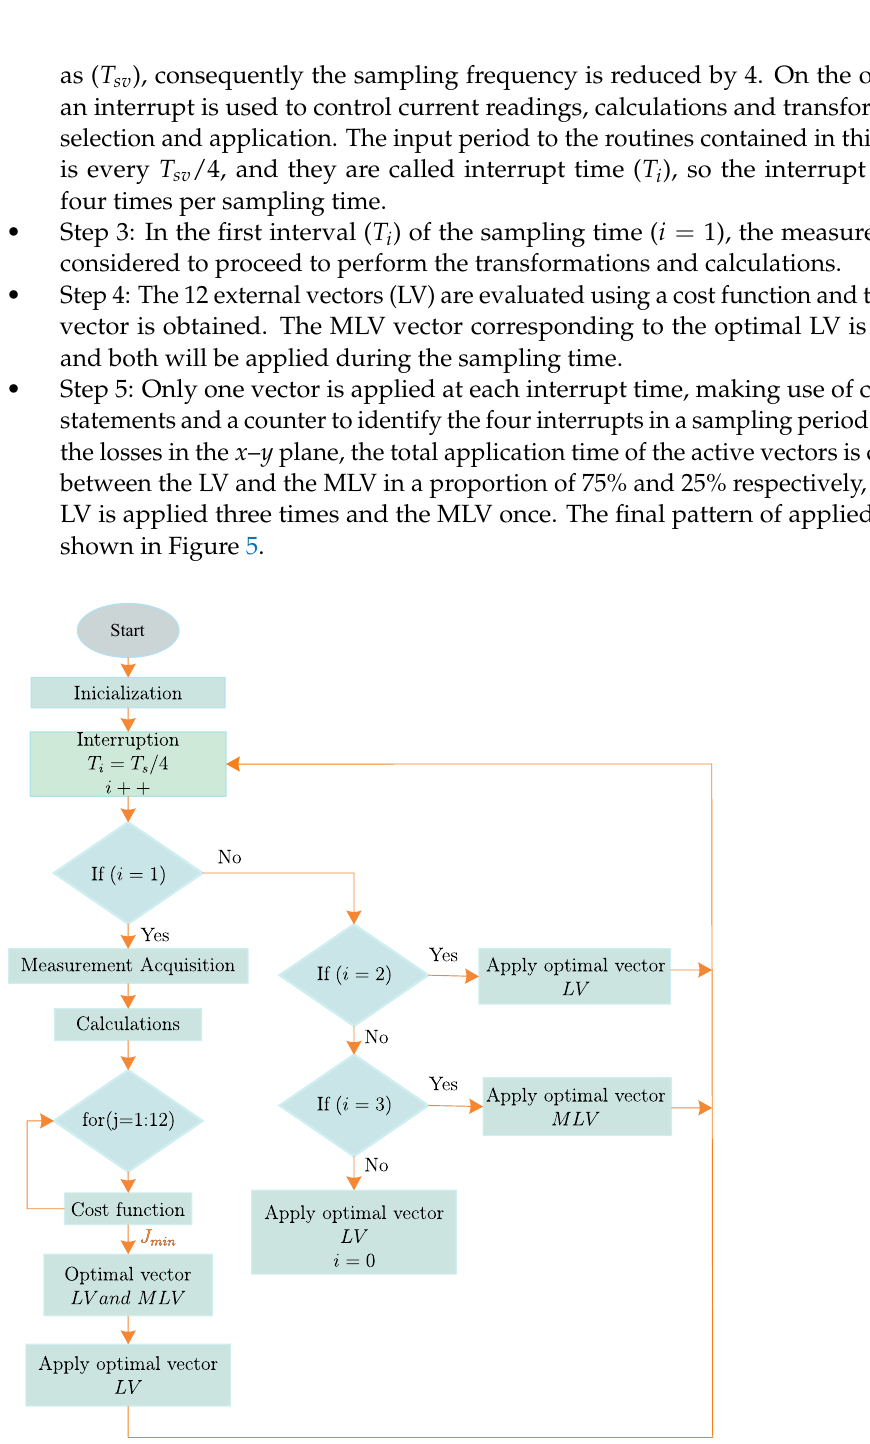
Figure 4. Algorithm diagram for VV4 technique.